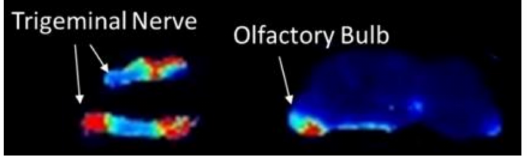
Figure 6. Spatial distribution of DiR in the brain two hours following intranasal administration of nanoparticles. DiR signal is highest in the trigeminal nerve and restricted regions of the ventral aspects of the brain, including striatum, midbrain, and brainstem.